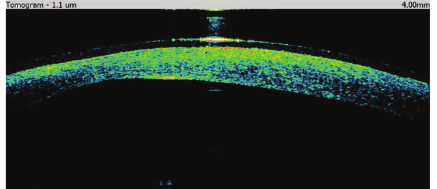
Figure 13: SOCT anterior: 1st postoperative day.